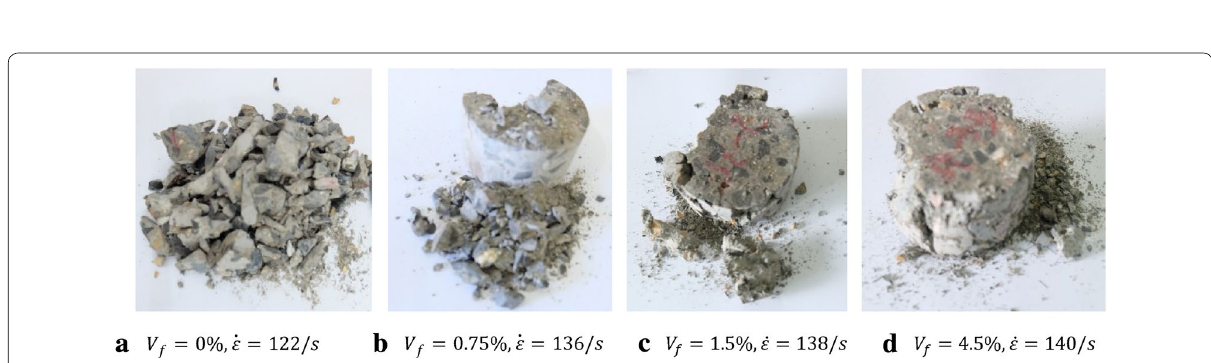
Fig. 10 Failure modes of SFRC with different fiber volume fractions at 20